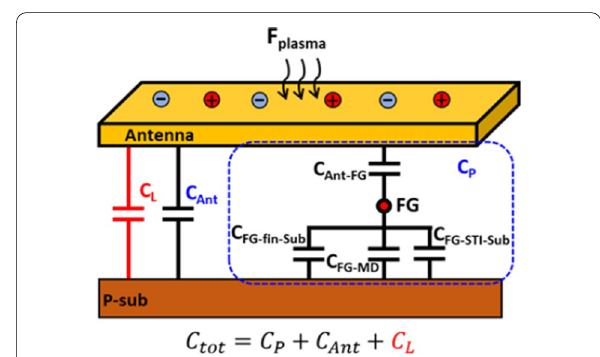
Fig. 4 Composition of capacitance on the antenna structure with the additional loading capacitor, which is designed to modify the sensitivity of the PID detectors. Where C P is the overall parasitic capacitance on the floating